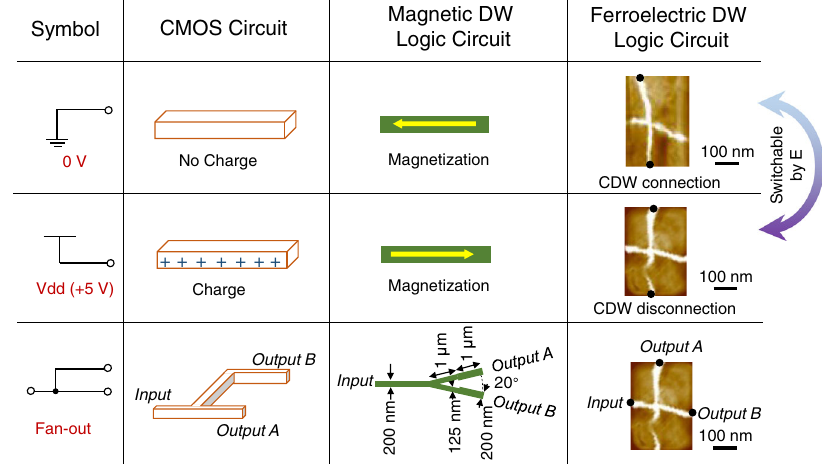
Fig. 5 Electric fi eld control of ferroelectric CDW logic circuits. Schematic illustration of the ferroelectric DW logic circuits for the readout signal of low and high voltages and the fan-out function. The bidirectional arrow indicates that the readout signals of low and high voltages can be transformed into each other by electric- fi eld-induced connection and disconnection of a CDW. The schematics for the CMOS circuit and magnetic DW logic circuit, redrawn from ref. 8 are also illustrated for comparison. E represents the applied in-plane electric fi